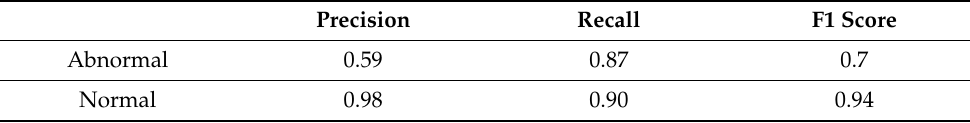
Figure 10. Confusion Matrix of the validation. Table 5. Testing results of the optimized CNN